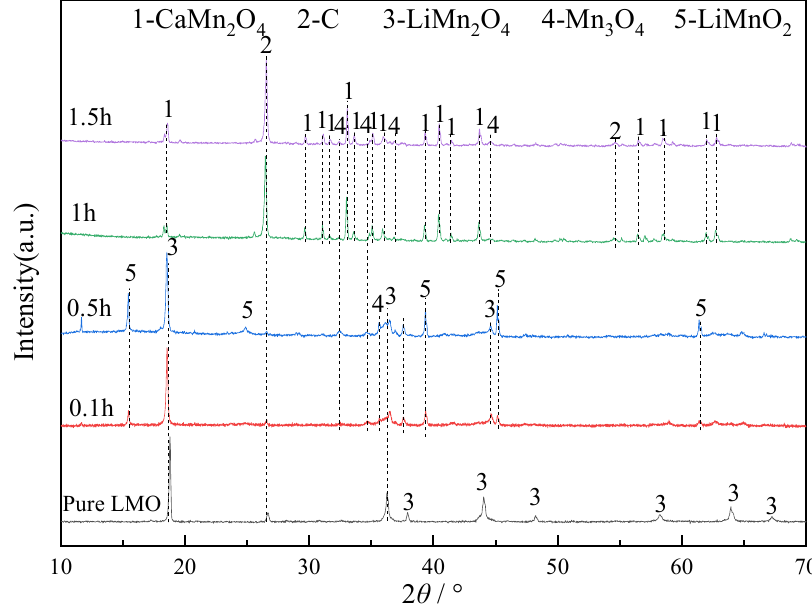
Figure 1. The product of LiMn 2 O 4 dissolving in molten salt was analyzed by XRD. When the holding time reaches 1~1.5 h, LiMn 2 O 4 and LiMnO 2 disappear, while calcium manganate (CaMn 2 O 4 ) and Mn 3 O 4 appear, indicating that LiMnO 2 generated by the decomposition of LiMn 2 O 4 is transformed into CaMn 2 O 4 during this time. The reaction formula is: The schematic diagram of the two-step reaction process is shown in Figure 2.